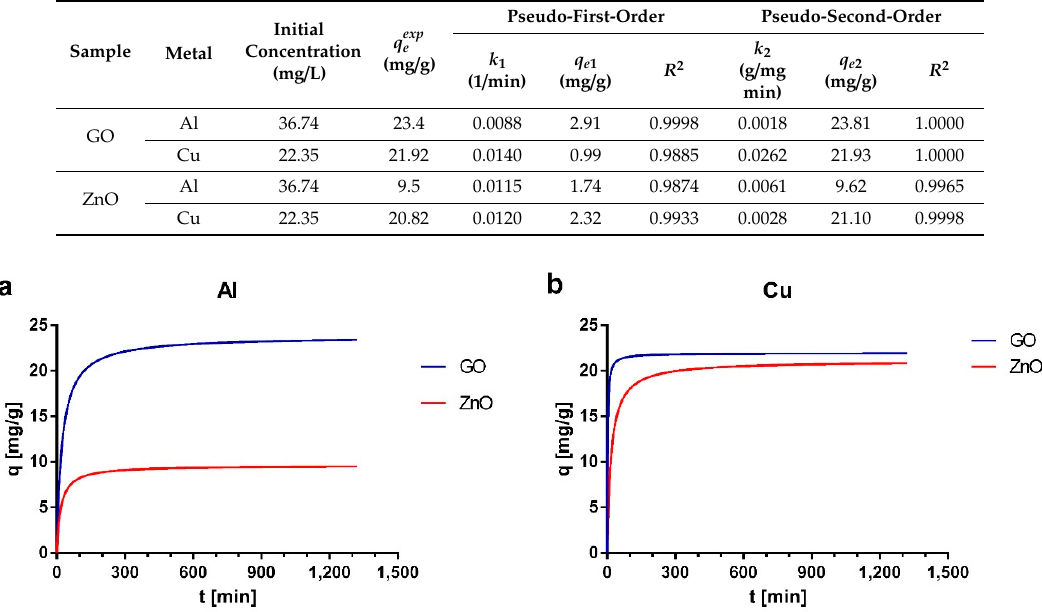
Table 2. Kinetic adsorption parameters for pseudo-first-order and pseudo-second-order models. Sampl